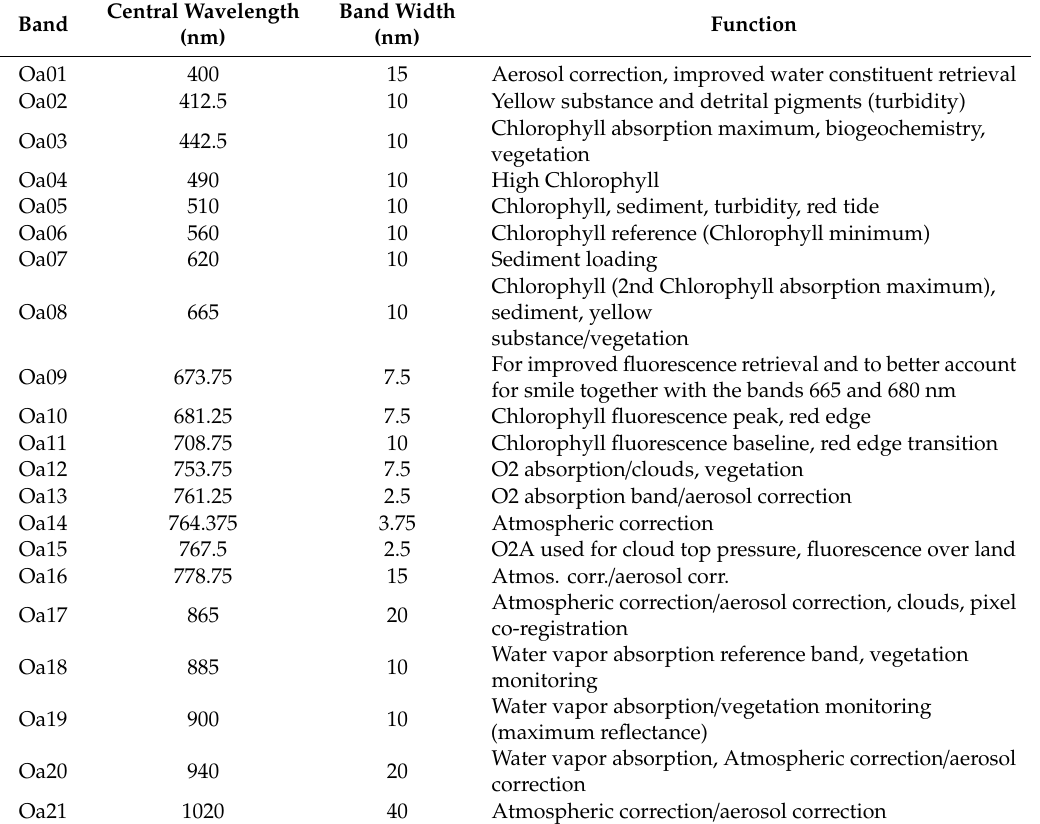
Table 1. Ocean Land Color Instrument (OLCI) spectral